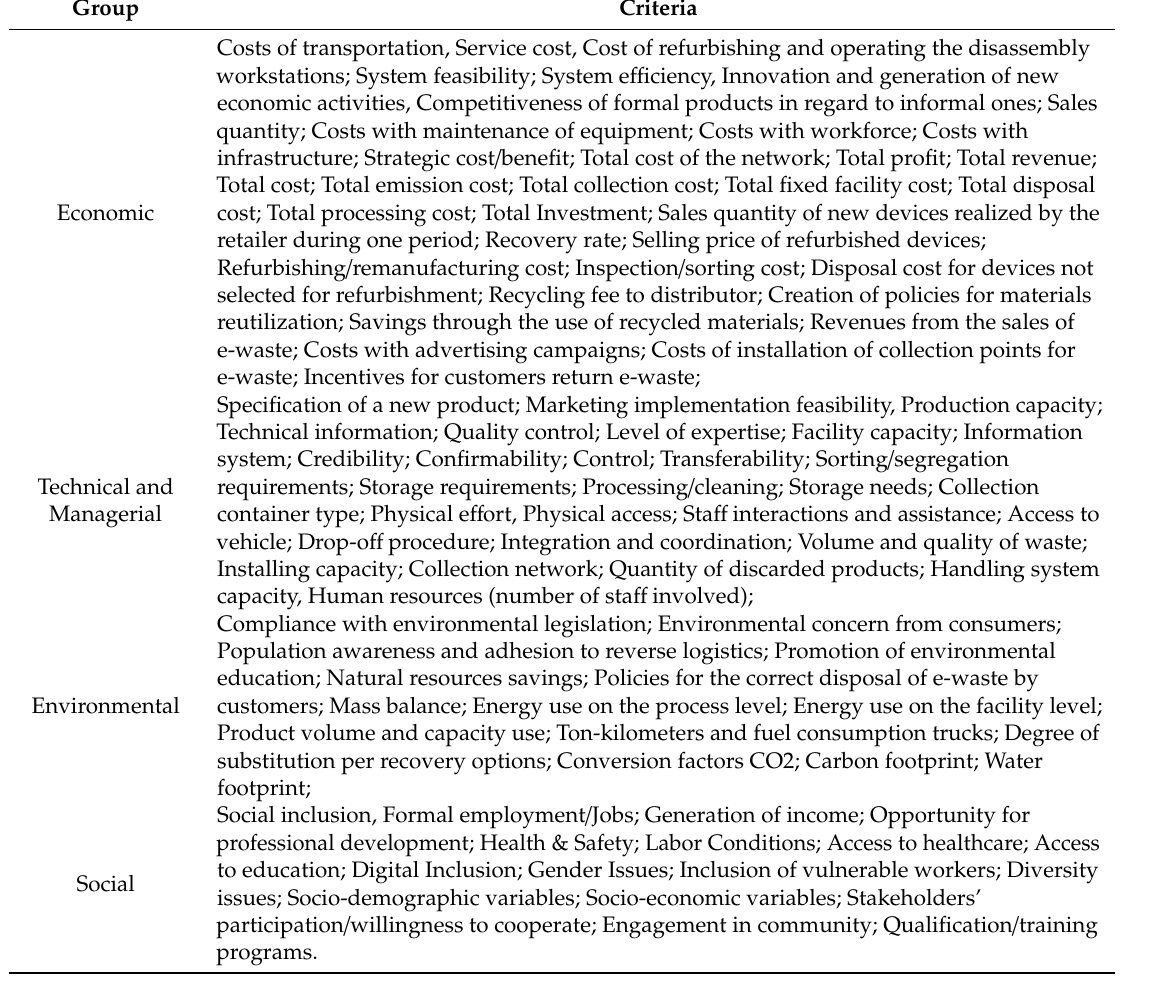
Table 9. Criteria to be included in the model based on the